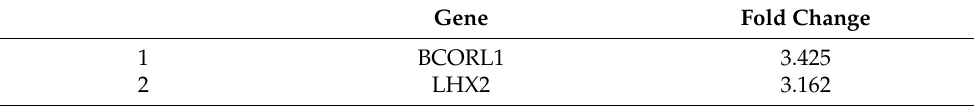
Table 12. Genes in epigenetic category that are downregulated in neural cells. Gene Fold Change 1 HENMT1 −